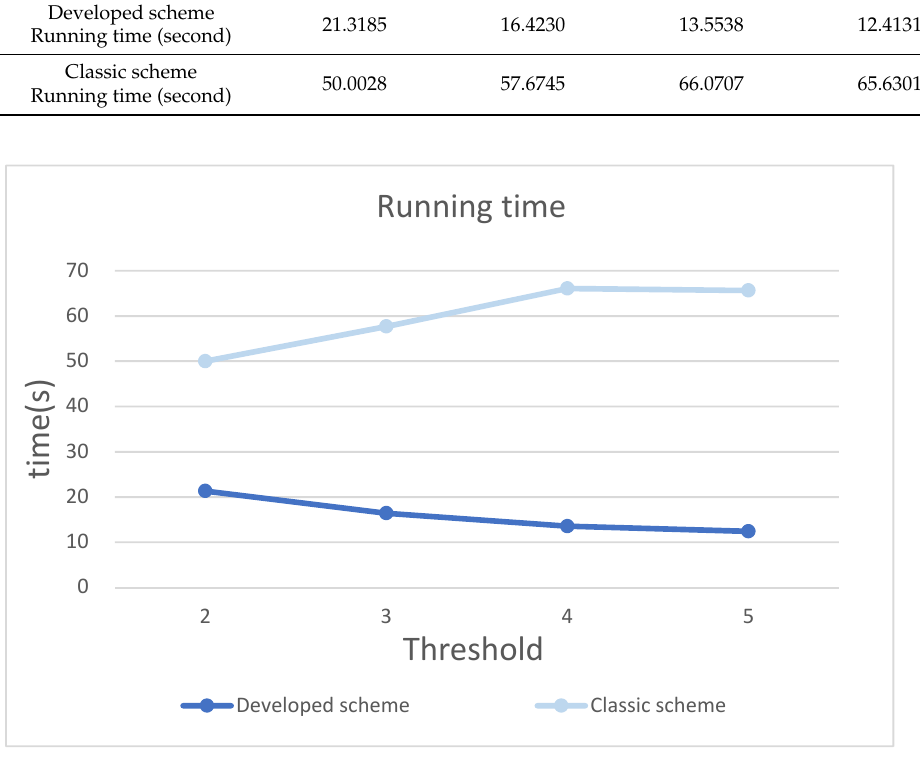
Figure 6. Running time comparison chart with different threshold in GF (2 8 ). Under the finite field GF (251), the running times for threshold values of k = 2, 3, 4, 5 are recorded respectively as shown in the following Table 2, and the running time comparison graphs are shown in Figure 7. Table 2. Running time in different threshold in GF